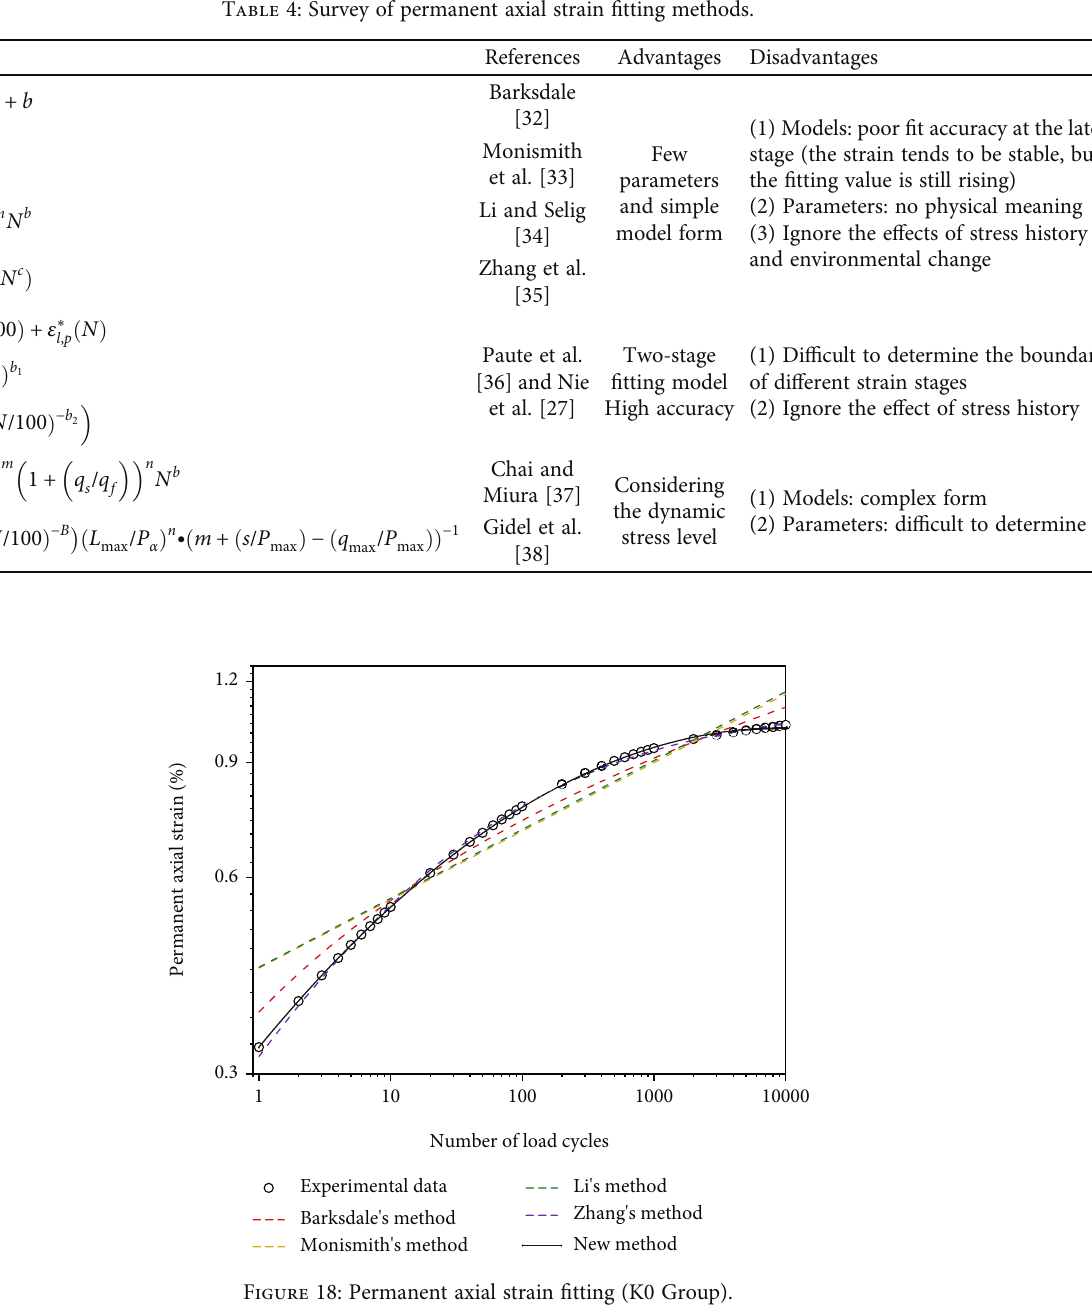
Table 4: Survey of permanent axial strain fi tting methods.